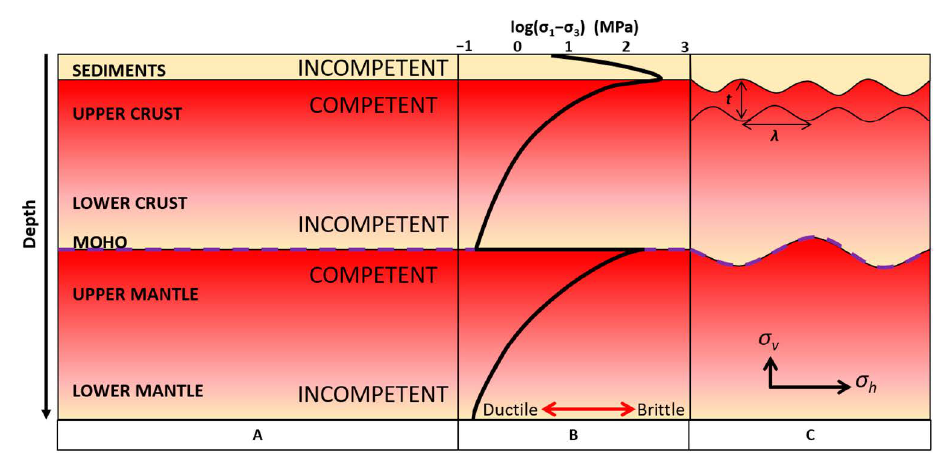
Figure 3. Idealized scheme depicting ( A ) lithosphere competency with increasing depth, ( B ) Strength profile redrafted with values from [49] and ( C ) conceptual effects of boudinage in the upper crust and lower crust/upper mantle region, in an anisotropic extensional regime